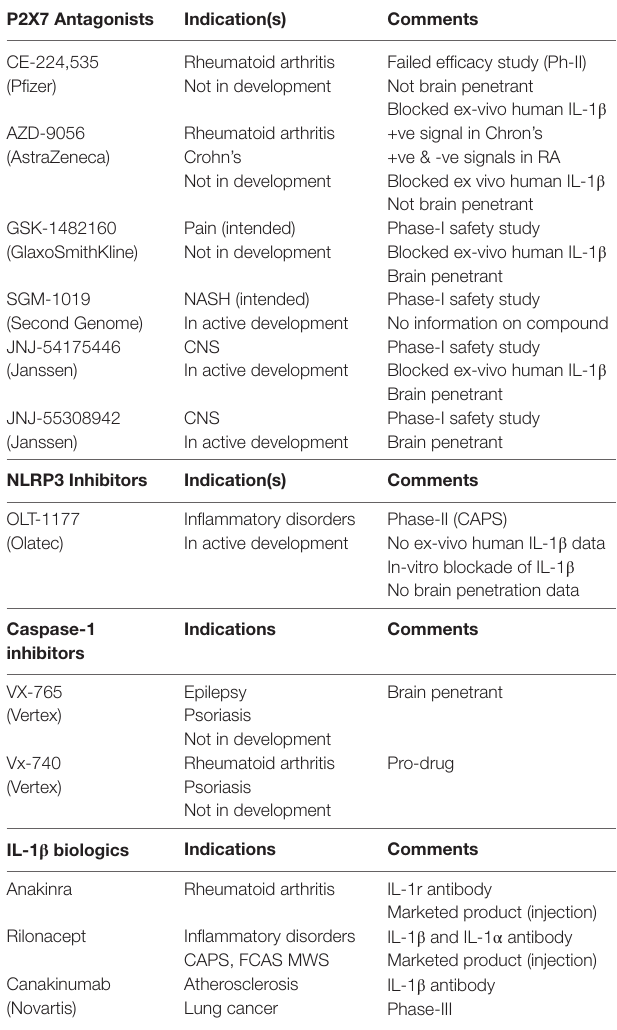
TABLE 2 | Clinical strategies used to dampen IL-1 β